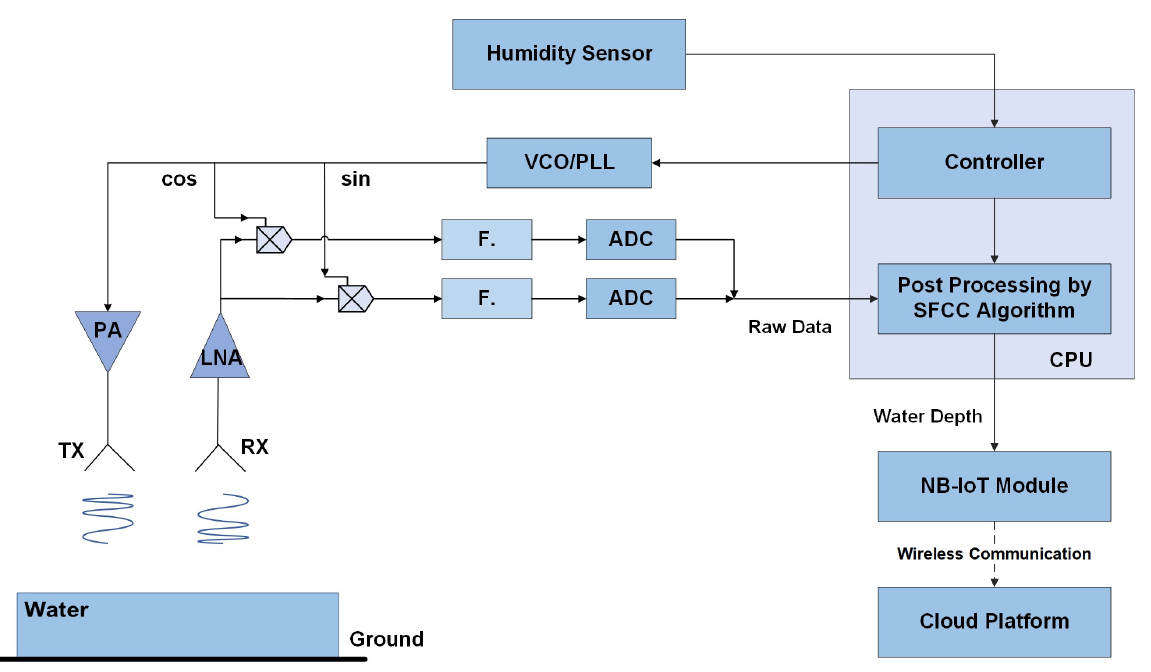
Figure 5. A block diagram of the system.